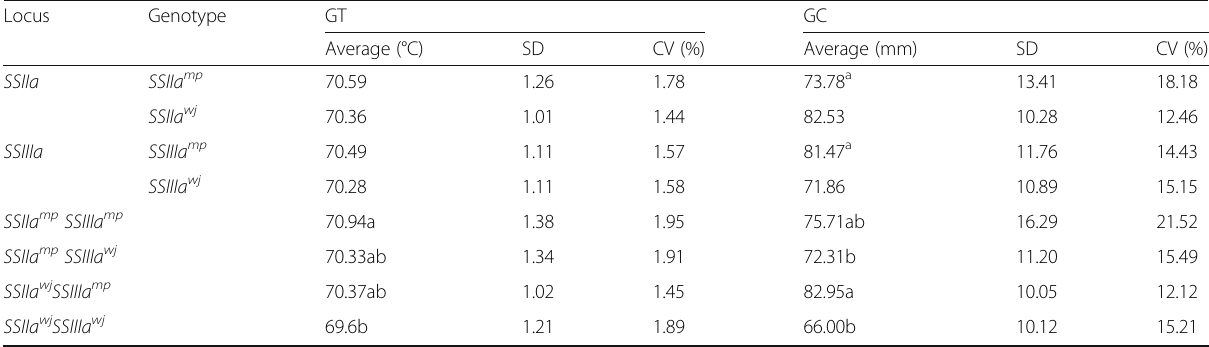
Table 6 Difference of GC and GT for different genotypes in SSIIa and SSIIIa locus of 64 5.-glutinous lines Locus